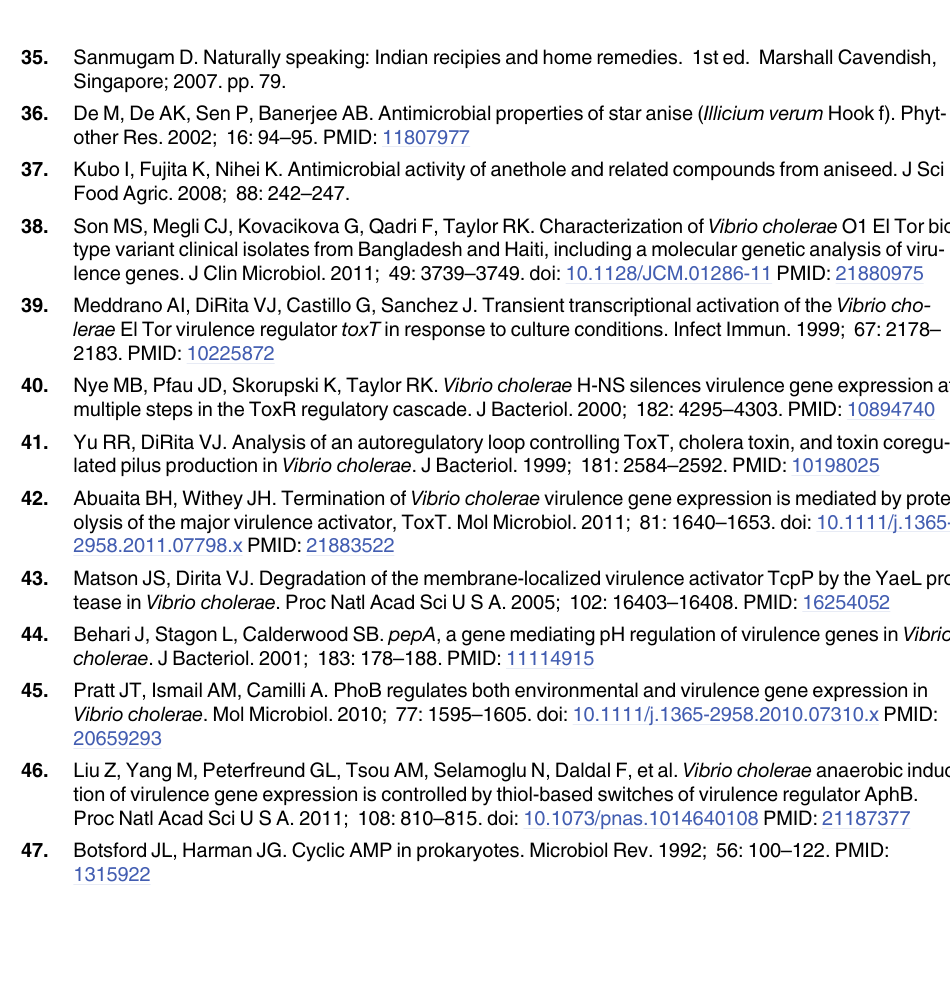
PLOS ONE | DOI:10.1371/journal.pone.0137529 September 11,